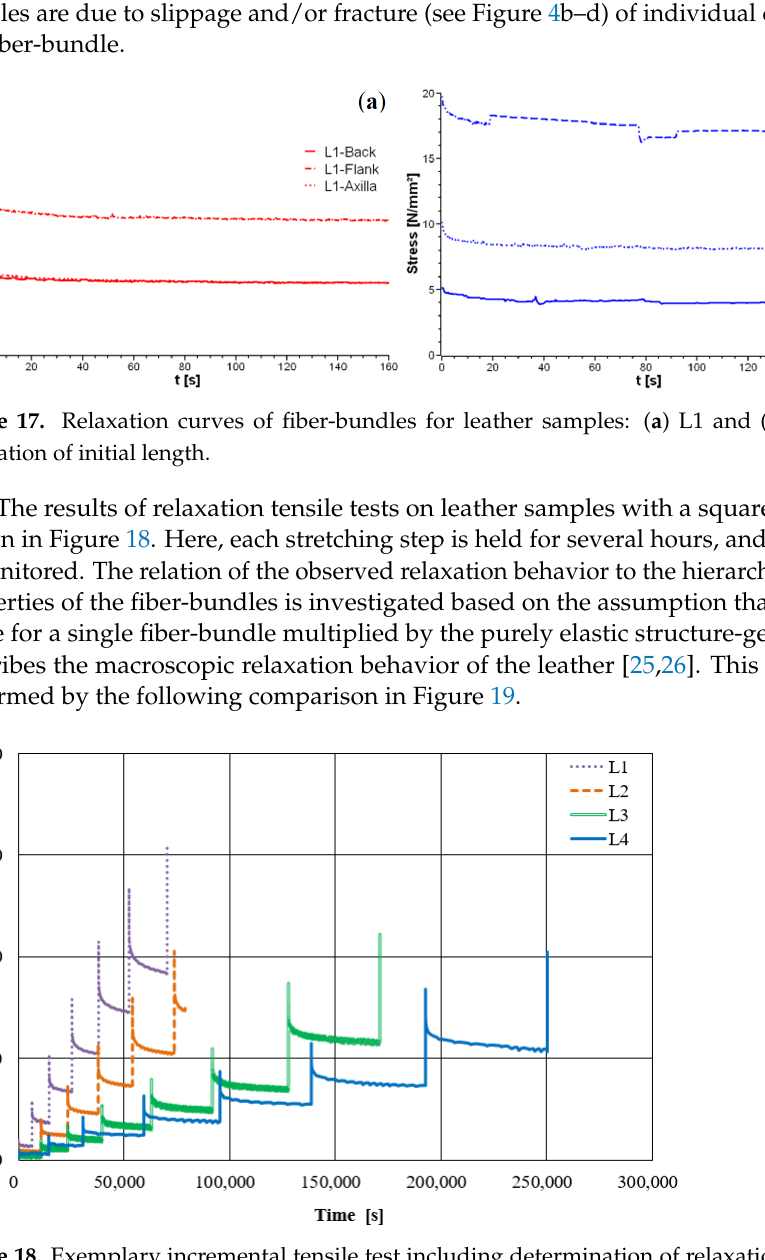
Figure 18. Exemplary incremental tensile test including determination of relaxation properties of leather